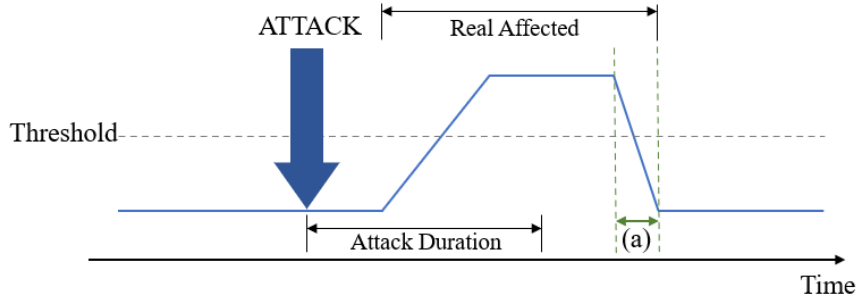
Figure 4. Example of an ambiguous section of the TaPR performance metric.